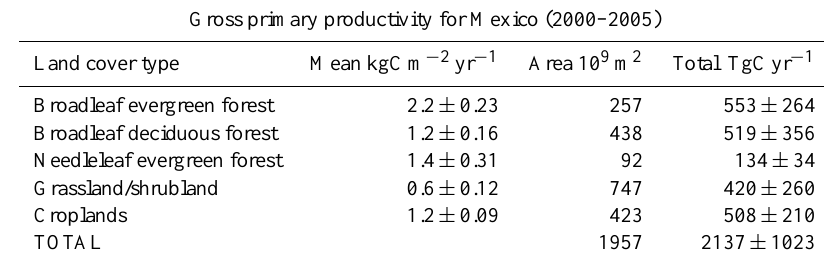
Table 3. Mean GPP, total area and total GPP by land cover type for the period 2000–2005.